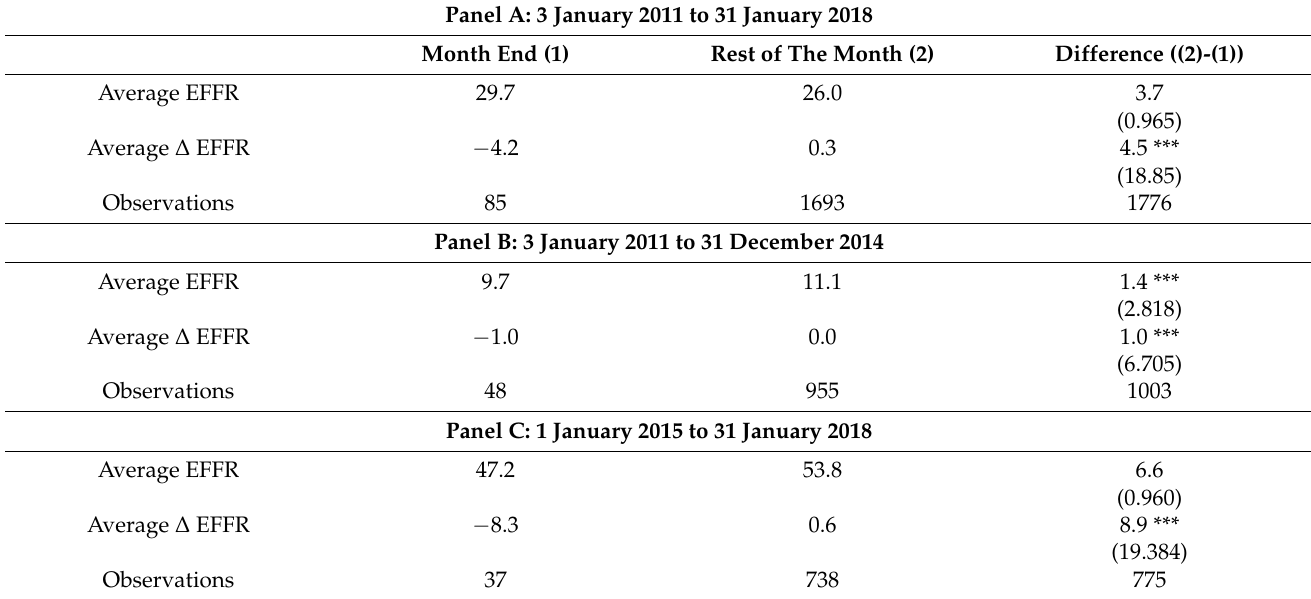
Table 3. Univariate (Means Difference)